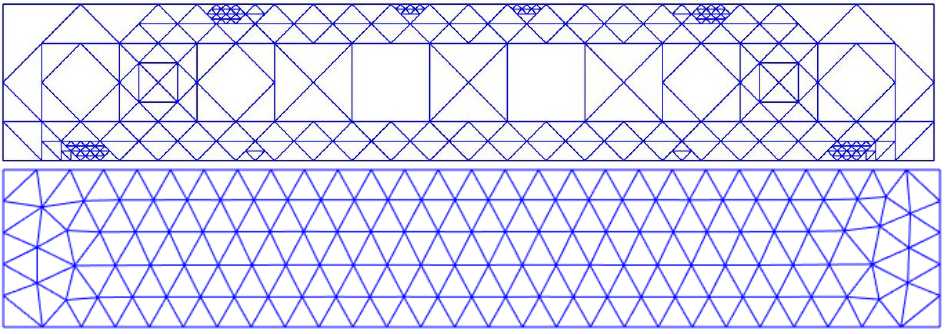
Figure 19. Part with optimised infill design ( top ) and uniform infill design ( bottom ).